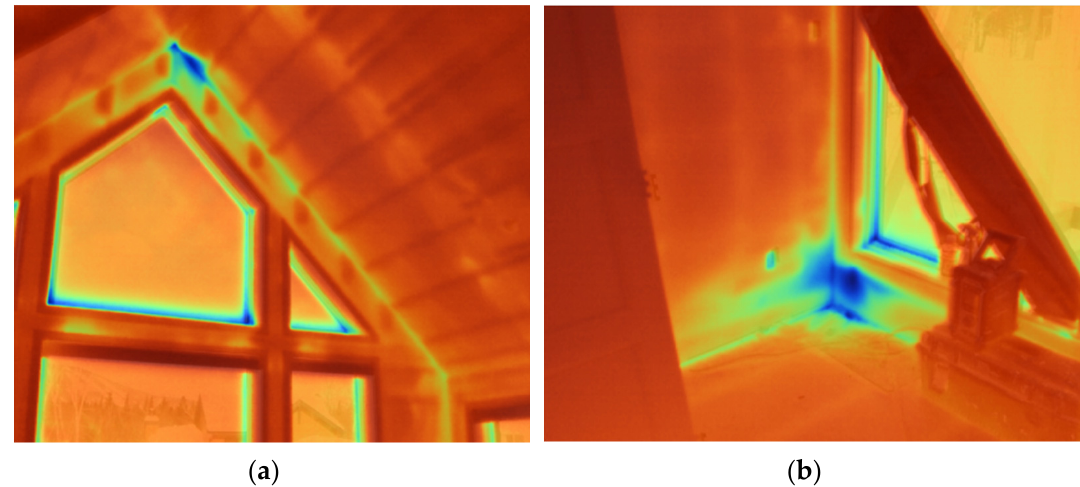
Figure 13. Larger air leakage observed from House A ( a ) and House B ( b ).